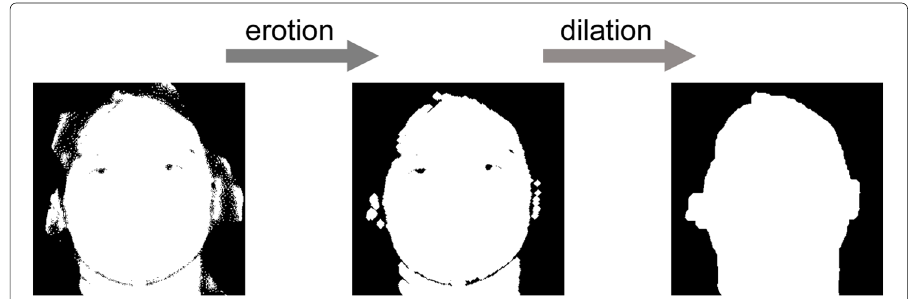
Fig. 4 Image morphological operations. An example of image dilation and erosion operation to remove the outliers and holes for a depth mask map